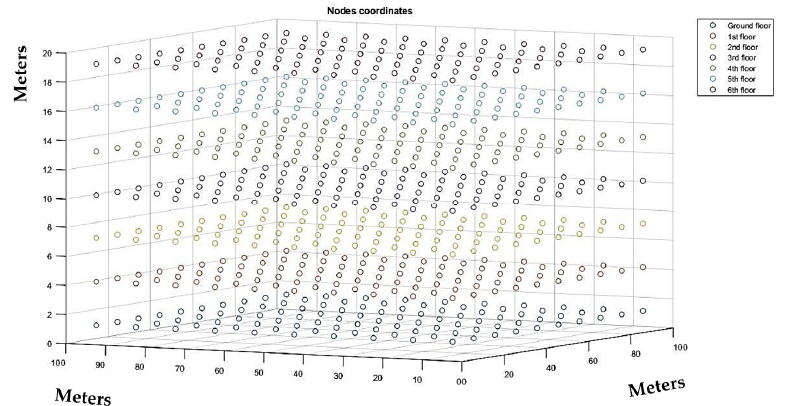
Figure 8. Topology of all installed IAQ nodes in the building in all three dimensions.